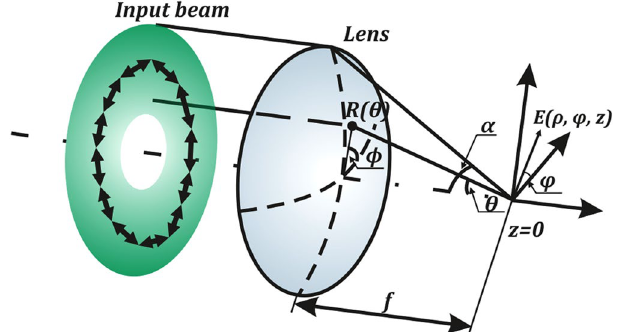
Figure 1. Vector Debye theory: focusing an azimuthally polarized beam through a lens of focal length f and maximum azimuthal angle α